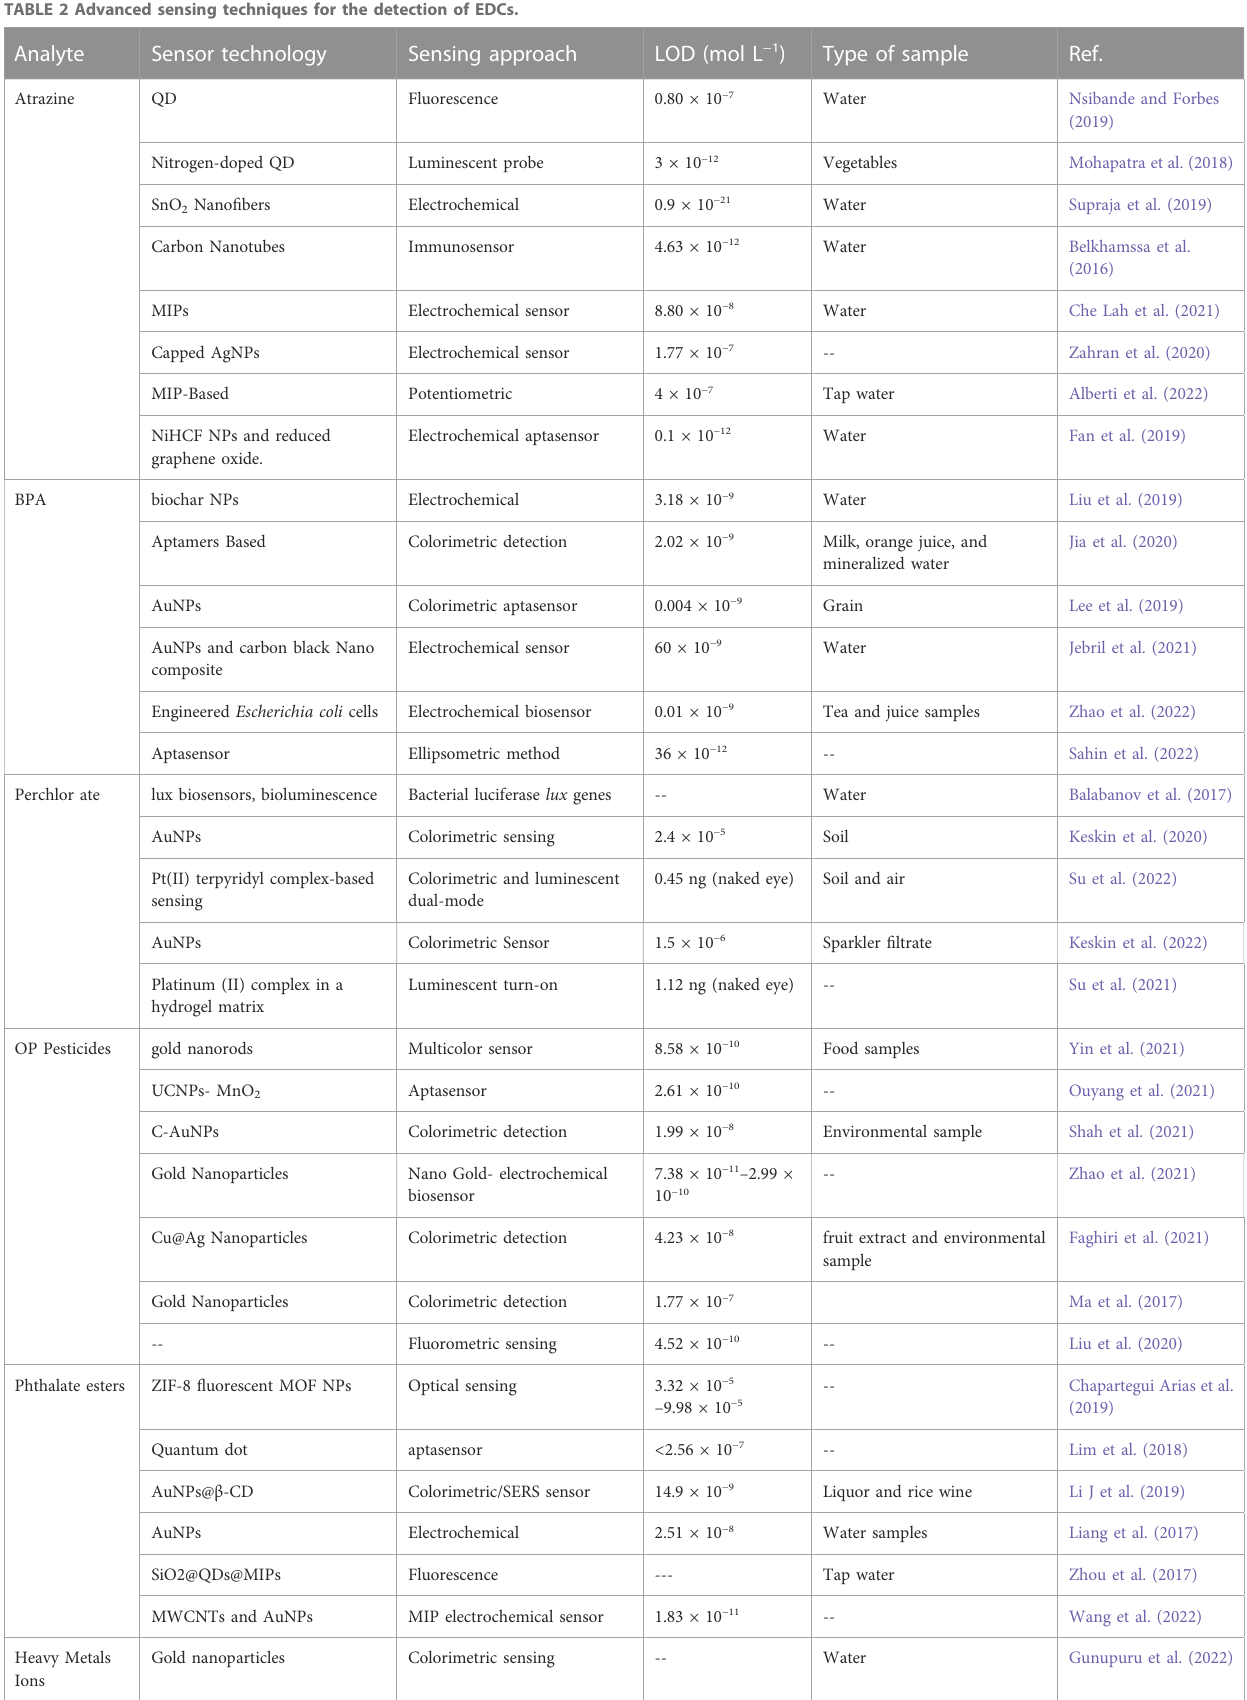
TABLE 2 Advanced sensing techniques for the detection of EDCs.